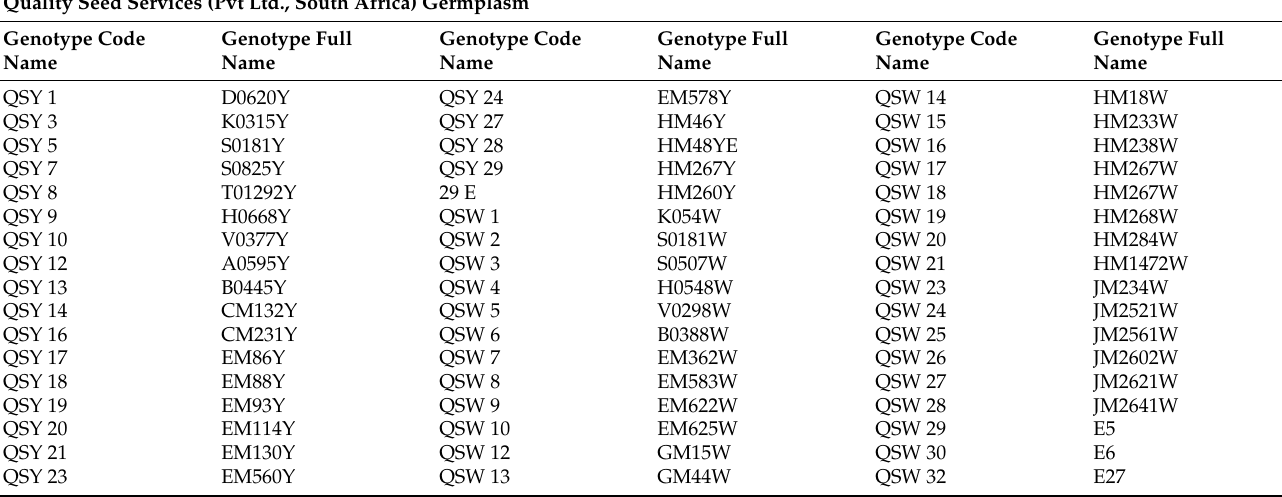
Table 5. Names and sources 75 QPM germplasm used in this